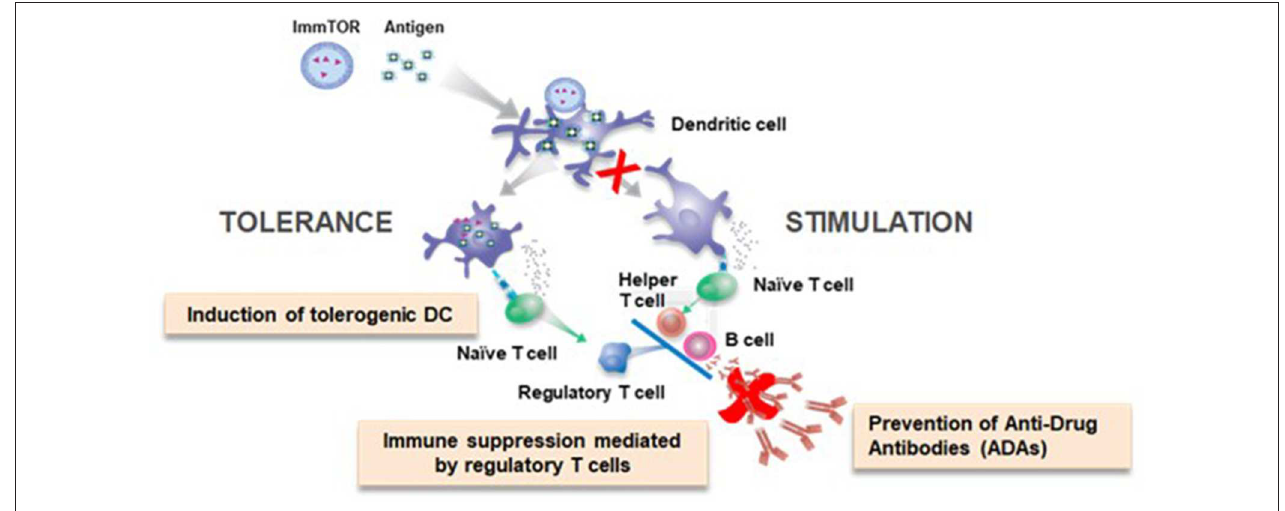
FIGURE 1 | ImmTOR co-administration with antigen elicits a tolerogenic immune